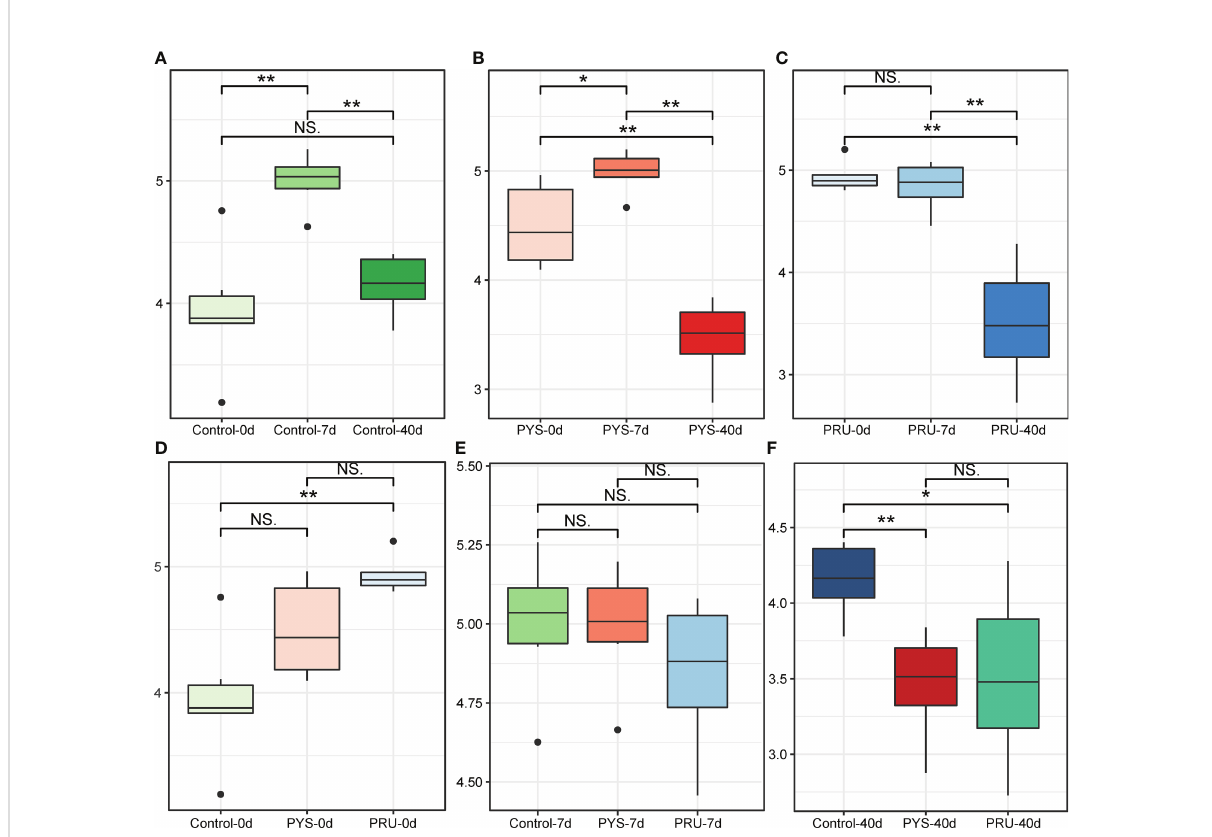
FIGURE 1 a diversity of gut microbiota in rats. (A – C) Shannon diversity index of control, PYS and PRU groups in different infection periods. (D – F) Shannon index of rats before infection, 7 and 40 days after infection, respectively. The signi fi cance level in the Wilcoxon rank sum test is denoted as: * p < 0.05 and ** p < 0.01. For boxplot, boxes represent the interquartile range between the fi rst and third quartiles and median (internal line); whiskers denote the lowest and highest values within 1.5 times range of the fi rst and third quartiles, respectively; and nodes represent outliers beyond the whiskers. NS means "Not signi fi